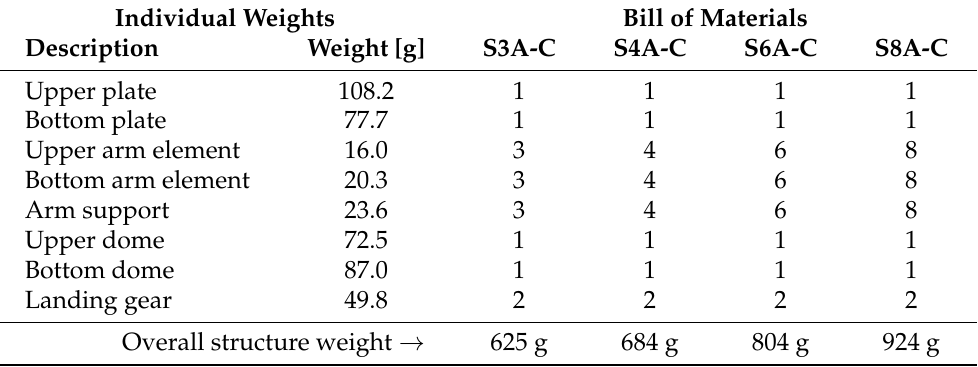
Table 7. PoliDrone frame weights